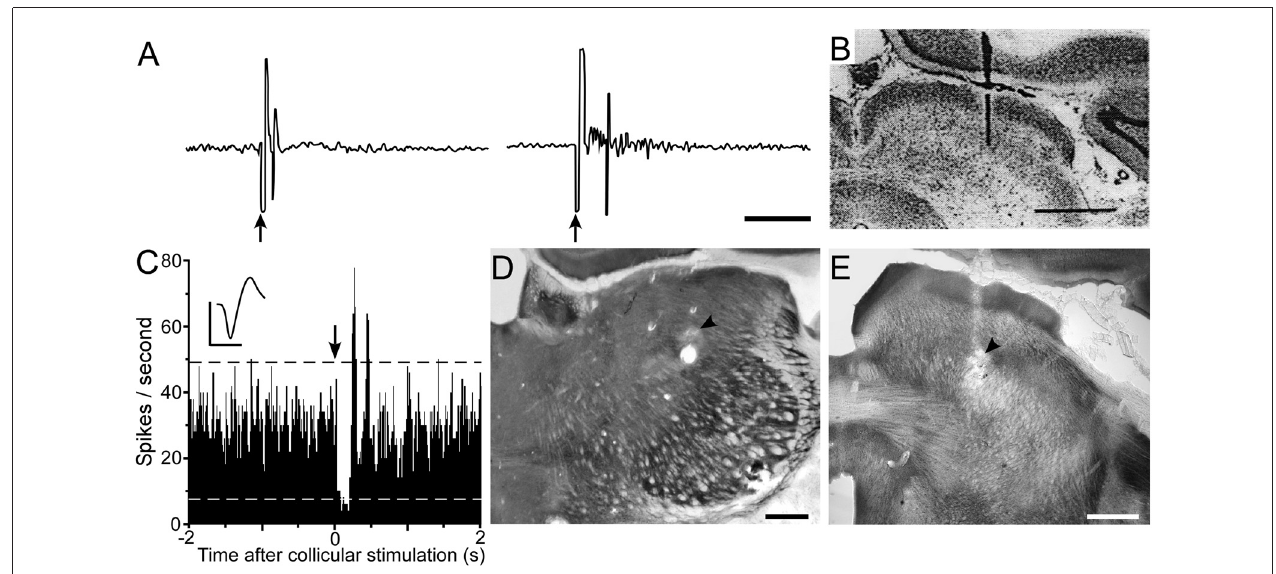
FIGURE 8 | Electrical stimulation of the superior colliculus exerts opposing influences on Pf and POm. (A) Excitatory responses recorded in the Pf and centrolateral nuclei following electrical stimulation (arrows) of the superior colliculus. (B) Histology shows location of bipolar stimulating electrode in superior colliculus. Data reprinted with permission (Grunwerg and Krauthamer, 1992). Scale Bars: 10 ms (A) , 1 mm (B) . (C) PSTH shows inhibition of POm activity following electrical stimulation (arrow) of superior colliculus. Waveform scales: 1 ms, 100 µ V. PSTH: 50 trials, 5-ms binwidths. (D,E) Photomicrographs depicting recording and stimulating sites (arrowheads) in POm and superior colliculus. Adapted from Watson et al.